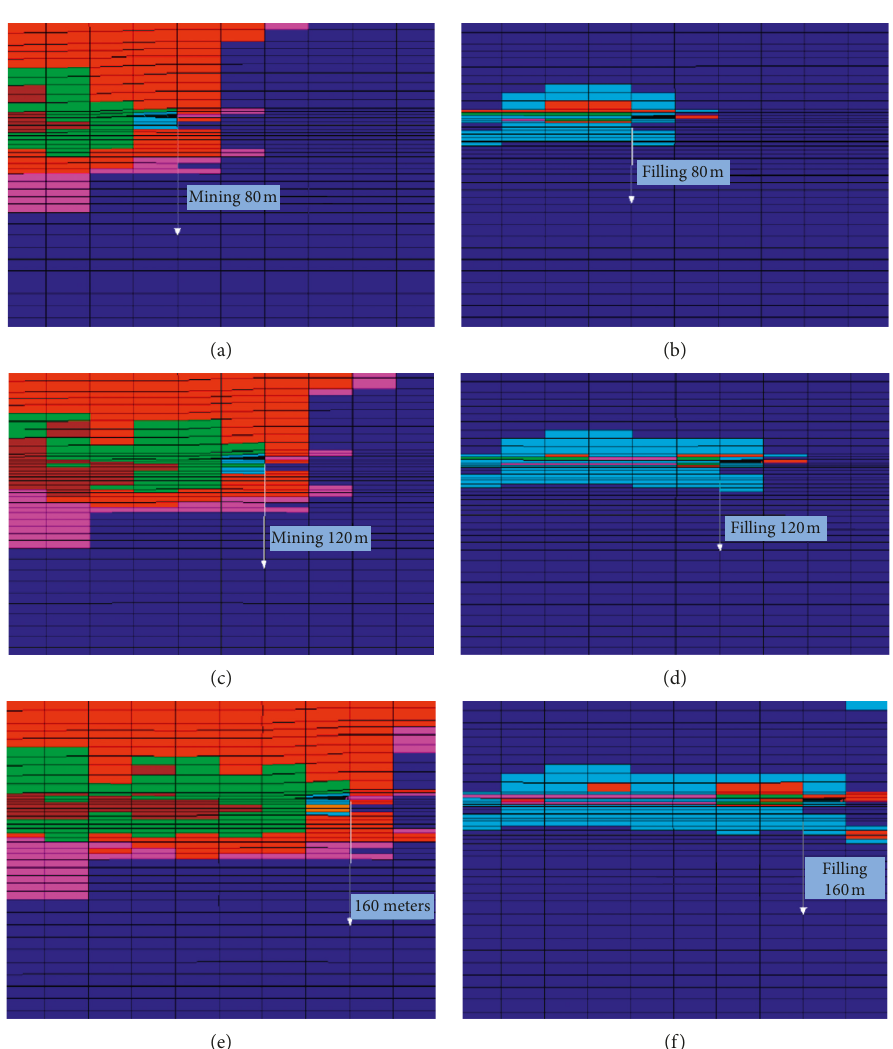
Figure 11: Development range of the plastic zone for the floor at different advance distances: 80m mining advance by (a) caving and (b) backfilling; 120m mining advance by (c) caving and (d) backfilling; and 160m mining advance by (e) caving and (f) backfilling.